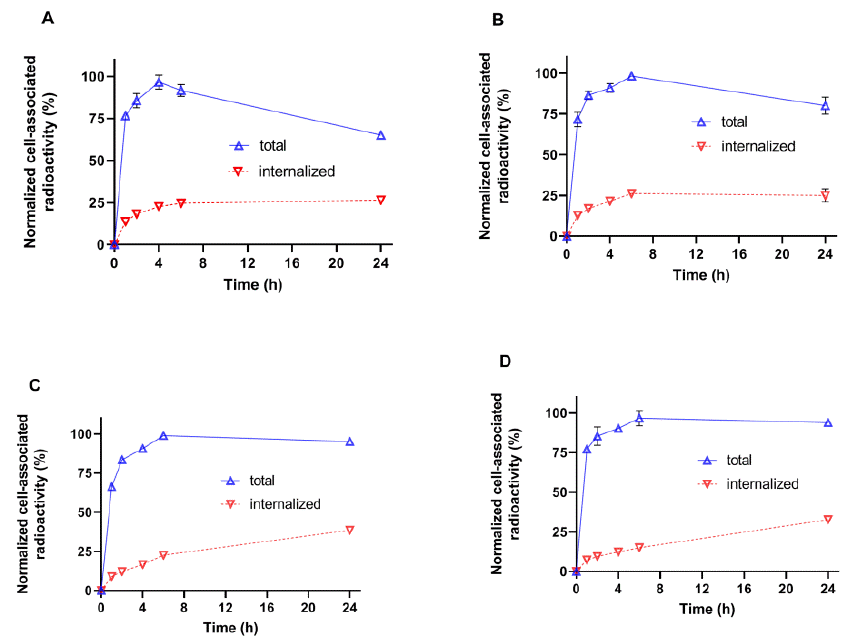
Figure 5. Cellular processing of radiolabeled G3 variants by HER2 ‐ expressing SKOV ‐ 3 cells in vitro.